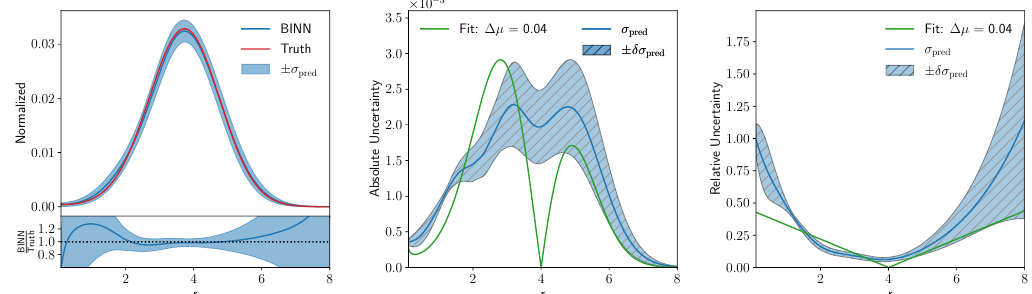
Figure 6: Cartesian density and predictive uncertainty distribution for the Gaussian ring. In the left panel the density and uncertainty are averaged over several lines with constant φ . In the central and right panels, the uncertainty band on σ given by their variation. The green curve represents a two-parameter fit to